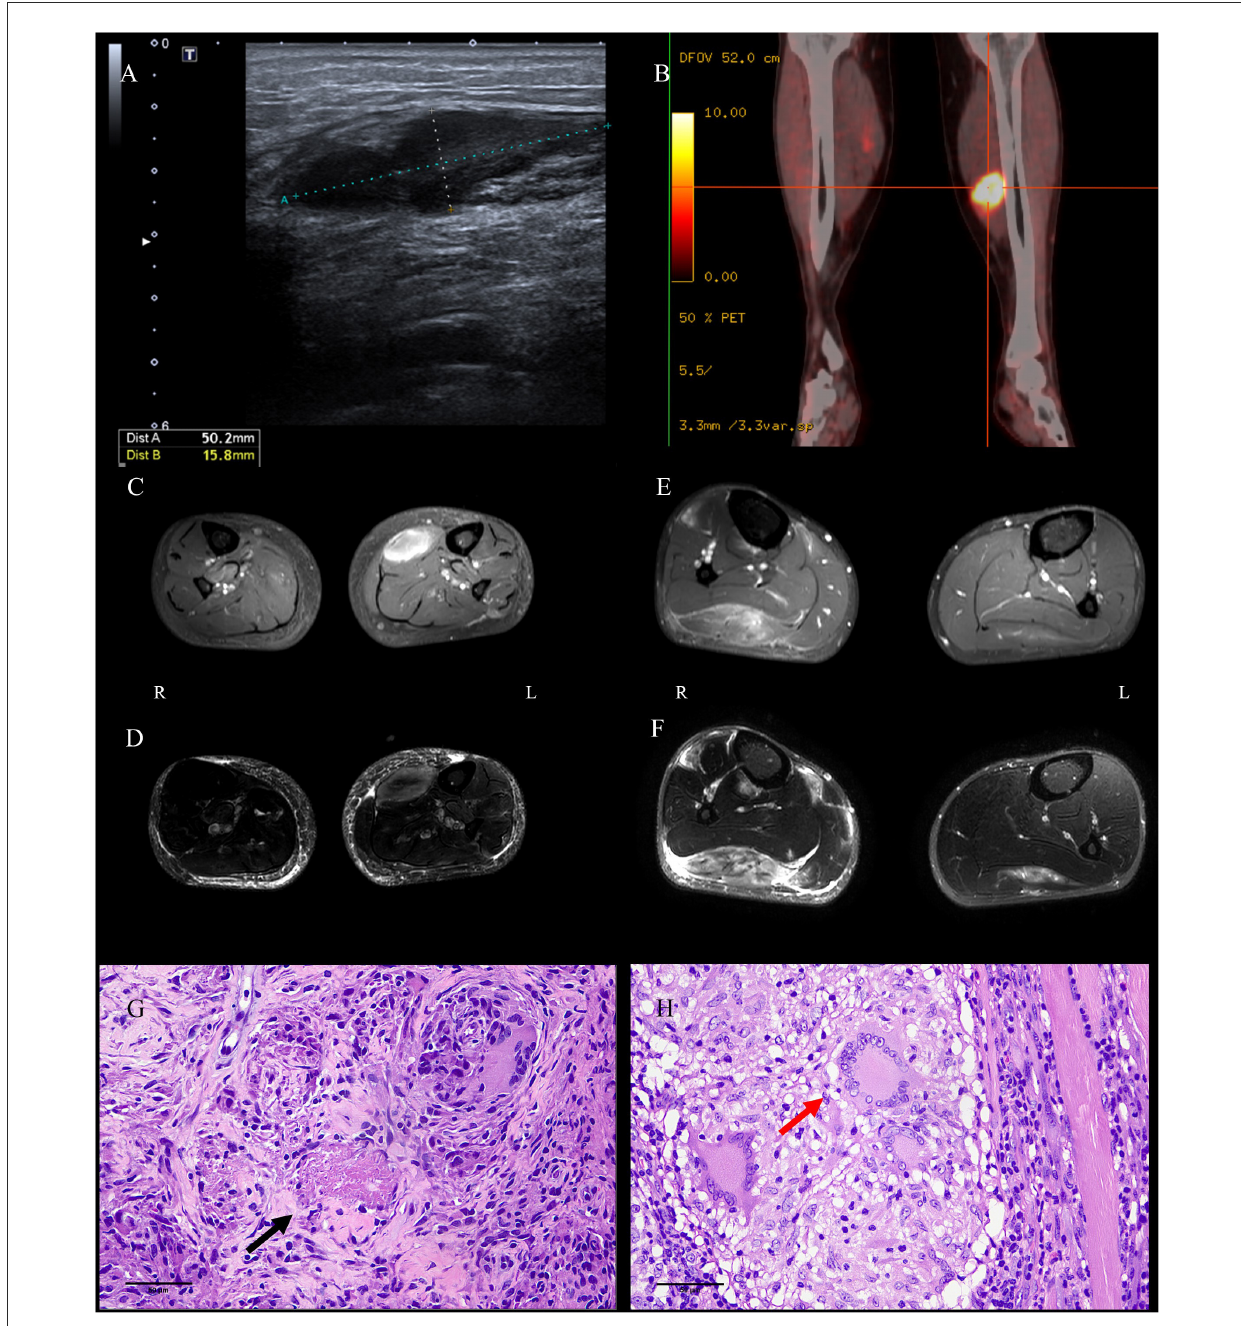
FIGURE1 Images and pathological findings of the muscle masses. The lesion in the left soleus muscle of P1 was found to be hypoechoic on ultrasound (A) , hypermetabolic on PETCT (B) , enhanced on axial enhanced T1WI-TES (C) , and light-hyperintense on T2W-SPAIR (D) . Several well-formed epithelioid granulomas centered by caseous necrosis were observed [ (G) , HE, bar = 50 µ m]. The lesion in the right gastrocnemius muscle of P2 was identified via enhancement on axial enhanced T1WI-TES (E) and hyperintensity on T2W-SPAIR (F) . Three Langerhans cells in granulomas were noticed in the sections [ (H) , HE, bar = 50 µ m]. P, patient; PETCT, positron emission tomography–computed tomography; T1W-TSE, T1-weighted turbo spin echo; T2W-SPAIR, T2-weighted spectral presaturation attenuated inversion